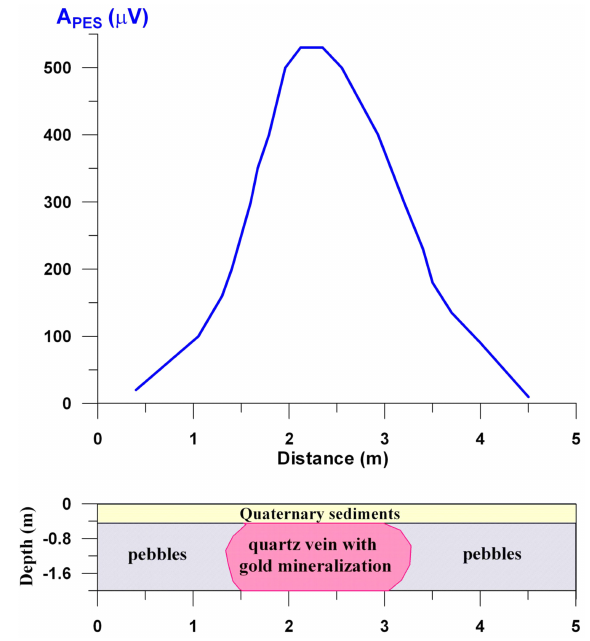
Fig. 16. Piezoelectric anomaly over an ancient gold-bearing mine, Southern Israel (after Neishtadt et al.,